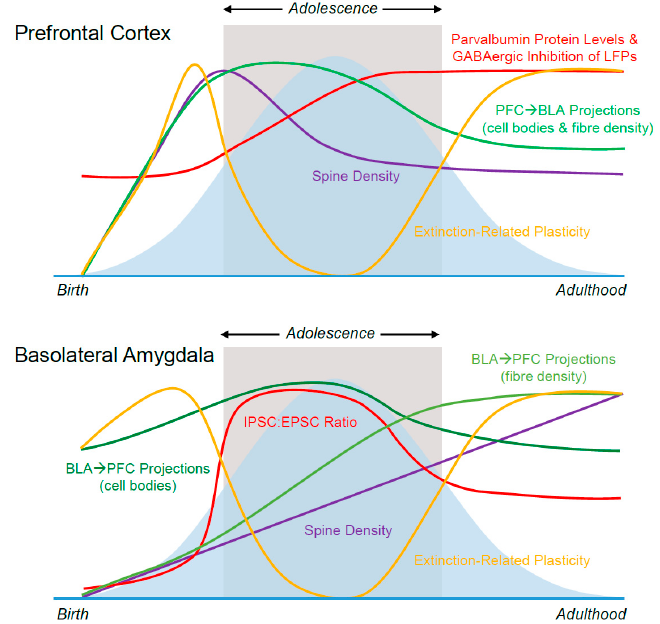
Figure 3. Summary of Neuroanatomical Changes Across Development. Blue bell curve represents fear relapse following extinction. Key: PFC, prefrontal cortex; BLA, basolateral amygdala; LFPs, local field potentials; I/EPSC, inhibitory/excitatory postsynaptic current.